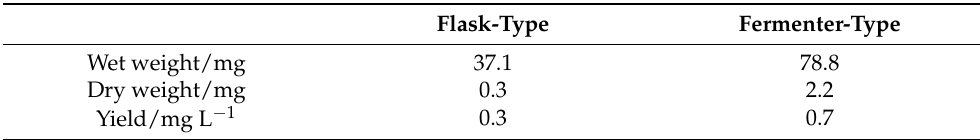
Table 1. Yields of magnetosomes by flask and fermenter cultures.